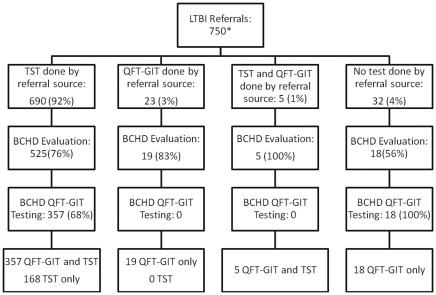
Flow of LTBI patient evaluation and testing at BCHD in the post-QFT-GIT period.*Among 750 referrals, 690 had a TST by referring source, 23 had a QFT-GIT by the referring source, and 5 had both a QFT-GIT and TST performed by referral source); 32 individuals were referred as B-Waivers without prior LTBI testing based on abnormal CXR during immigration. Among 567 referrals that came to BCHD for evaluation, 525 were referred with a TST result and 19 for a positive QFT-GIT and 5 individuals had both a QFT-GIT and TST performed by referral source; 18 B-waiver referrals were evaluated without prior LTBI testing. Among these 567 referrals, 168 had only a TST (30%), 37 had only a QFT-GIT (67), and 362 (64%) had both a TST and a QFT-GIT test result. Of 399 QFT-GIT test results among referrals evaluated by BCHD, 375 had QFT-GIT testing at BCHD and 24 had QFT-GIT testing from referral source.